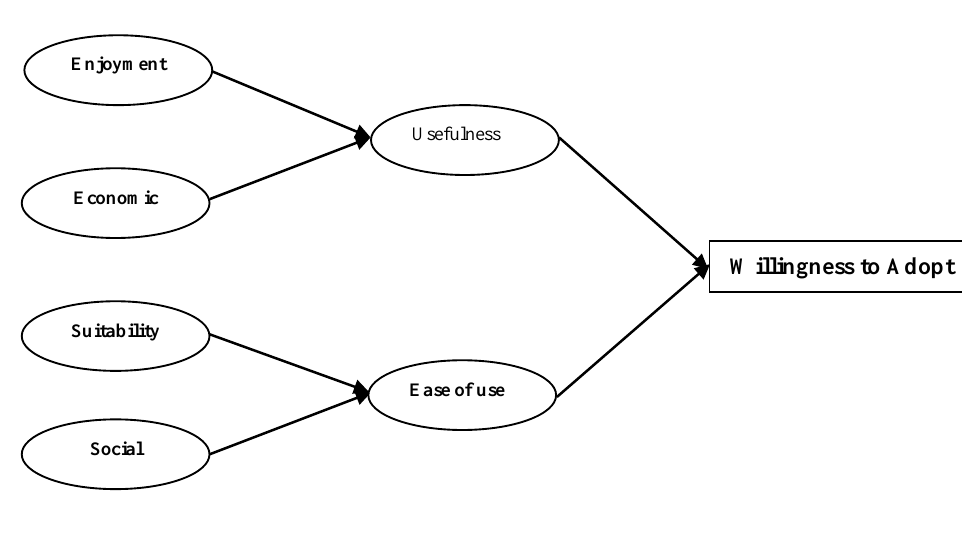
Figure 1 . Research